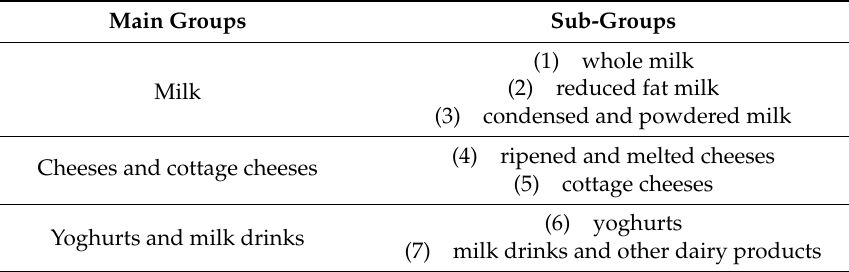
Table 2. Main groups and sub-groups in the category of milk and dairy products. Main